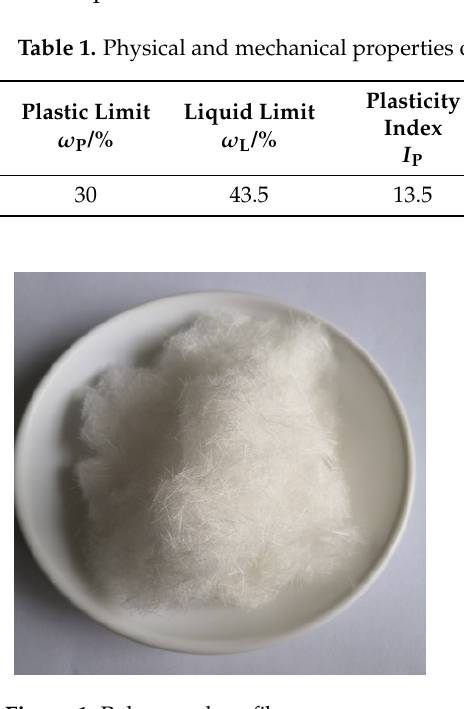
Figure 1. Polypropylene fibers. Table 2. Physical and mechanical properties of polypropylene fiber. Table 1. Physical and mechanical properties of coastal soft clay.